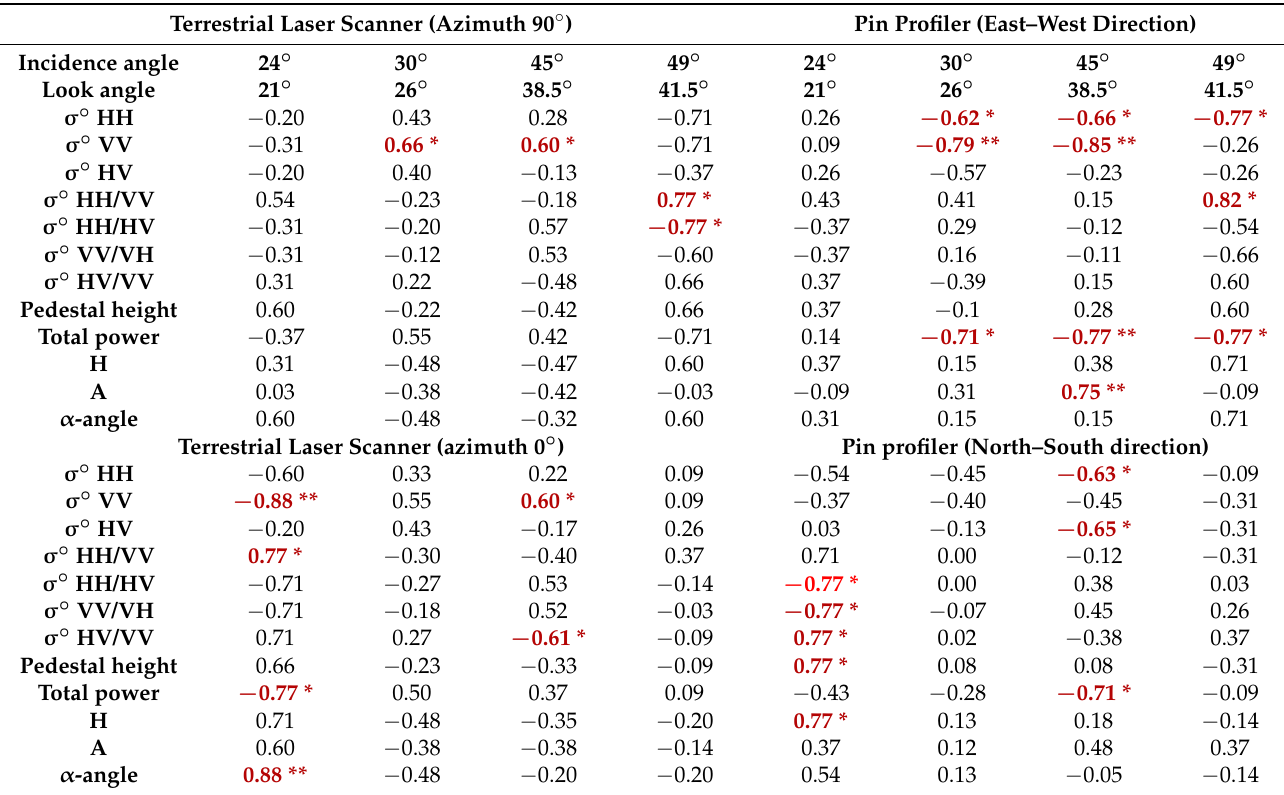
Table 3. Comparing the Spearman correlation coefficients ( p value) between averaged polarimetric variables and mean RMSH obtained with TLS and pin profiler in different orientations.